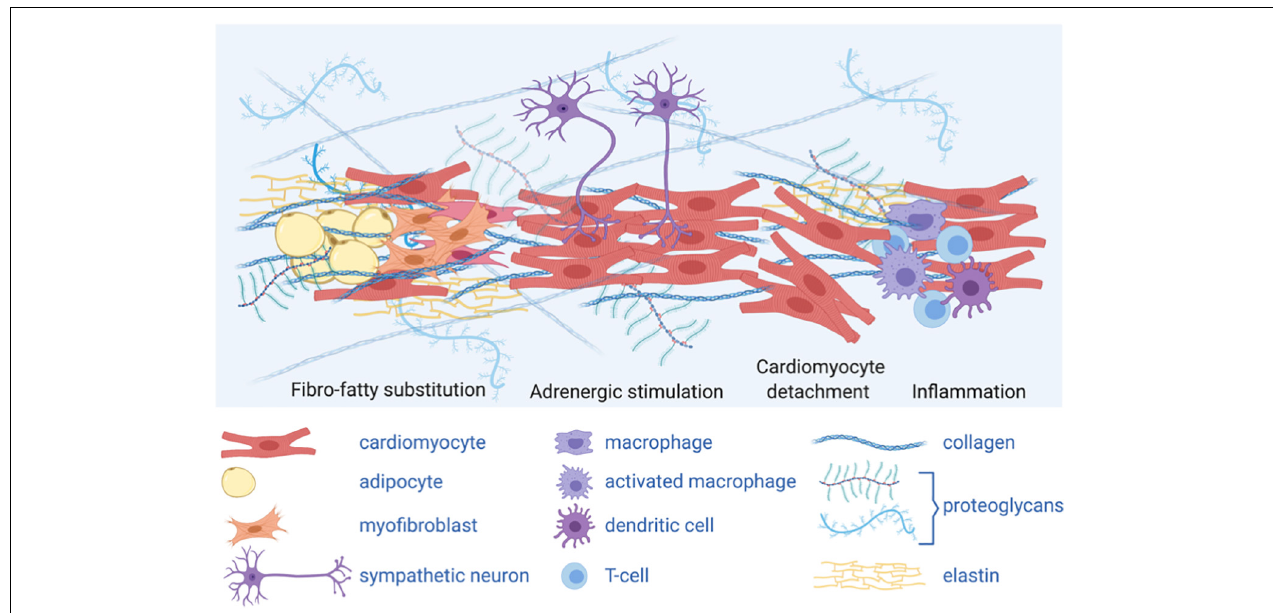
FIGURE 3 | A complex extracellular environment influences intracellular signaling in AC. Graphical representation of different cell types and extracellular matrix (ECM) composing AC heart micro-environment: adipocytes and ECM protein deposition, including collagen, secreted by activated fibroblasts (myofibroblasts) change the stiffness of the heart tissue, thus impacting mechanical stimuli; fibro-fatty substitution is likely secondary to cardiomyocyte damage and death; sympathetic neurons release catecholamines, acting as adrenergic stimuli; inflammatory cells are also present in the AC myocardium. The complex cardiac micro-environment is sensed by the cells and influences intracellular signaling and cell